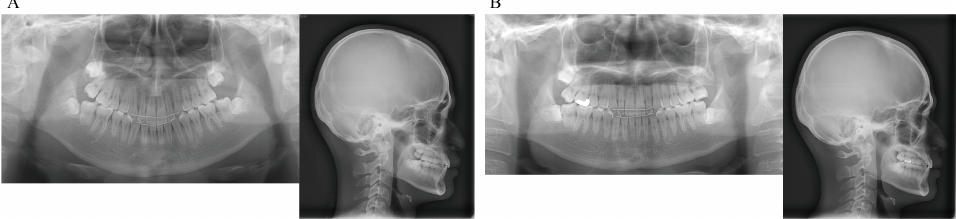
Figure 9. Panoramic radiographs and lateral cephalograms. ( A ) At termination of active treatment (age, 17 years 9 months). ( B ) At completion of eruption of the maxillary left third molar (age, 21 years 3